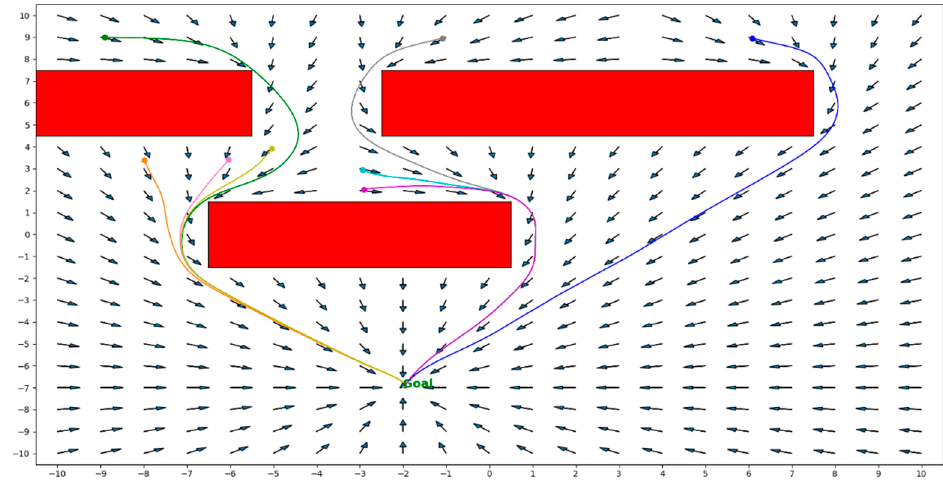
Figure 14. Sample trajectories after ELM initialization.